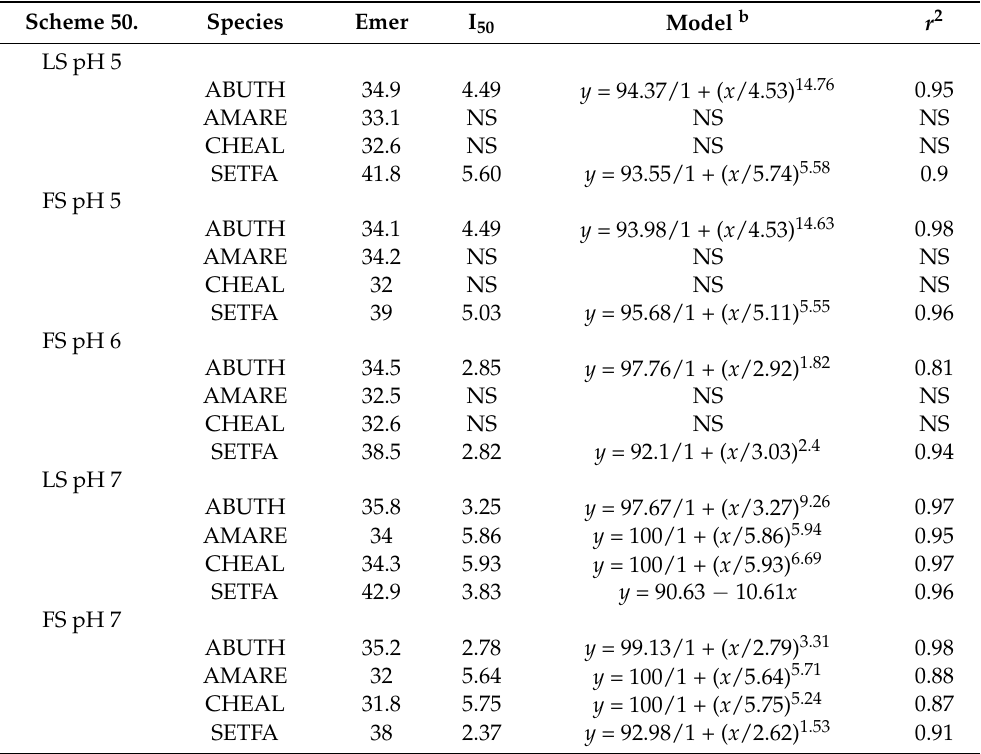
Table 5. Seedling emergence of various weed species averaged over time, I 50 , and regression equation used to model weed control for soil pHs a . Scheme